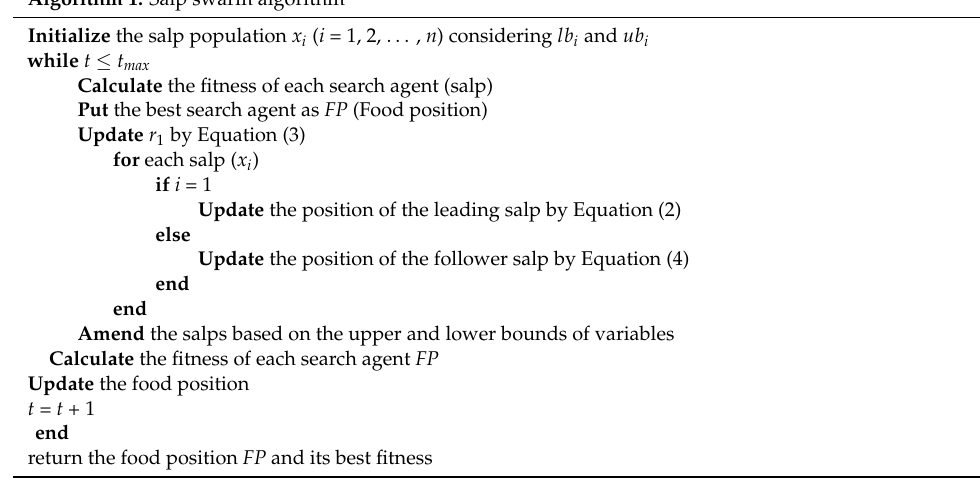
Algorithm 1. Salp swarm